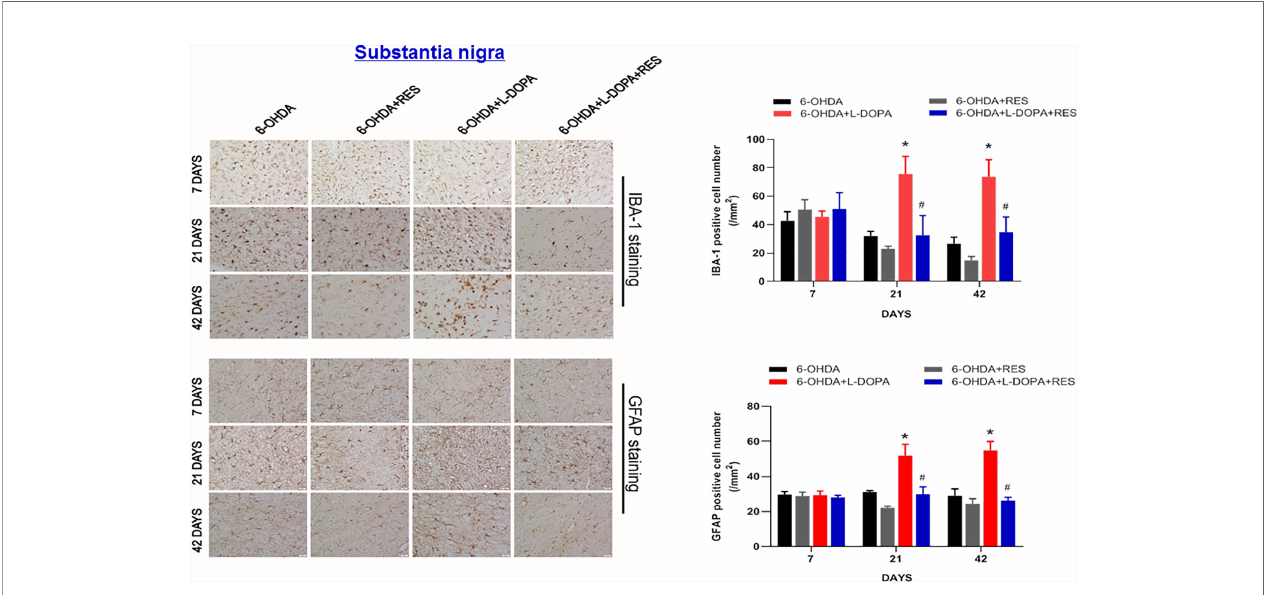
FIGURE 5 | Effects of RES on activation of glial cells in substantia nigra of rats with LID. Rat brains were sectioned and microglia and astroglia were immunostained with anti-GFAP and IBA-1 antibodies 7, 21, and 42 days after L-DOPA administration, respectively. The number analysis of IBA-1-positive microglia and GFAP- positive astroglia in substantia nigra from 3 evenly spaced brain sections of each rat was performed.Data were expressed as mean ± SEM from 5 rats and calculated as percentage of 6-OHDA values. * P < 0.05 compared with 6-OHDA group; # P < 0.05 compared with 6-OHDA+L-DOPA